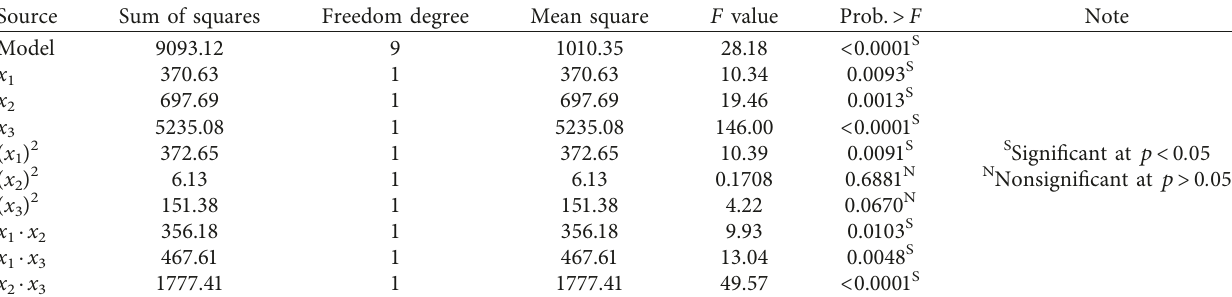
Table 4: ANOVA data for the IBU removal models.